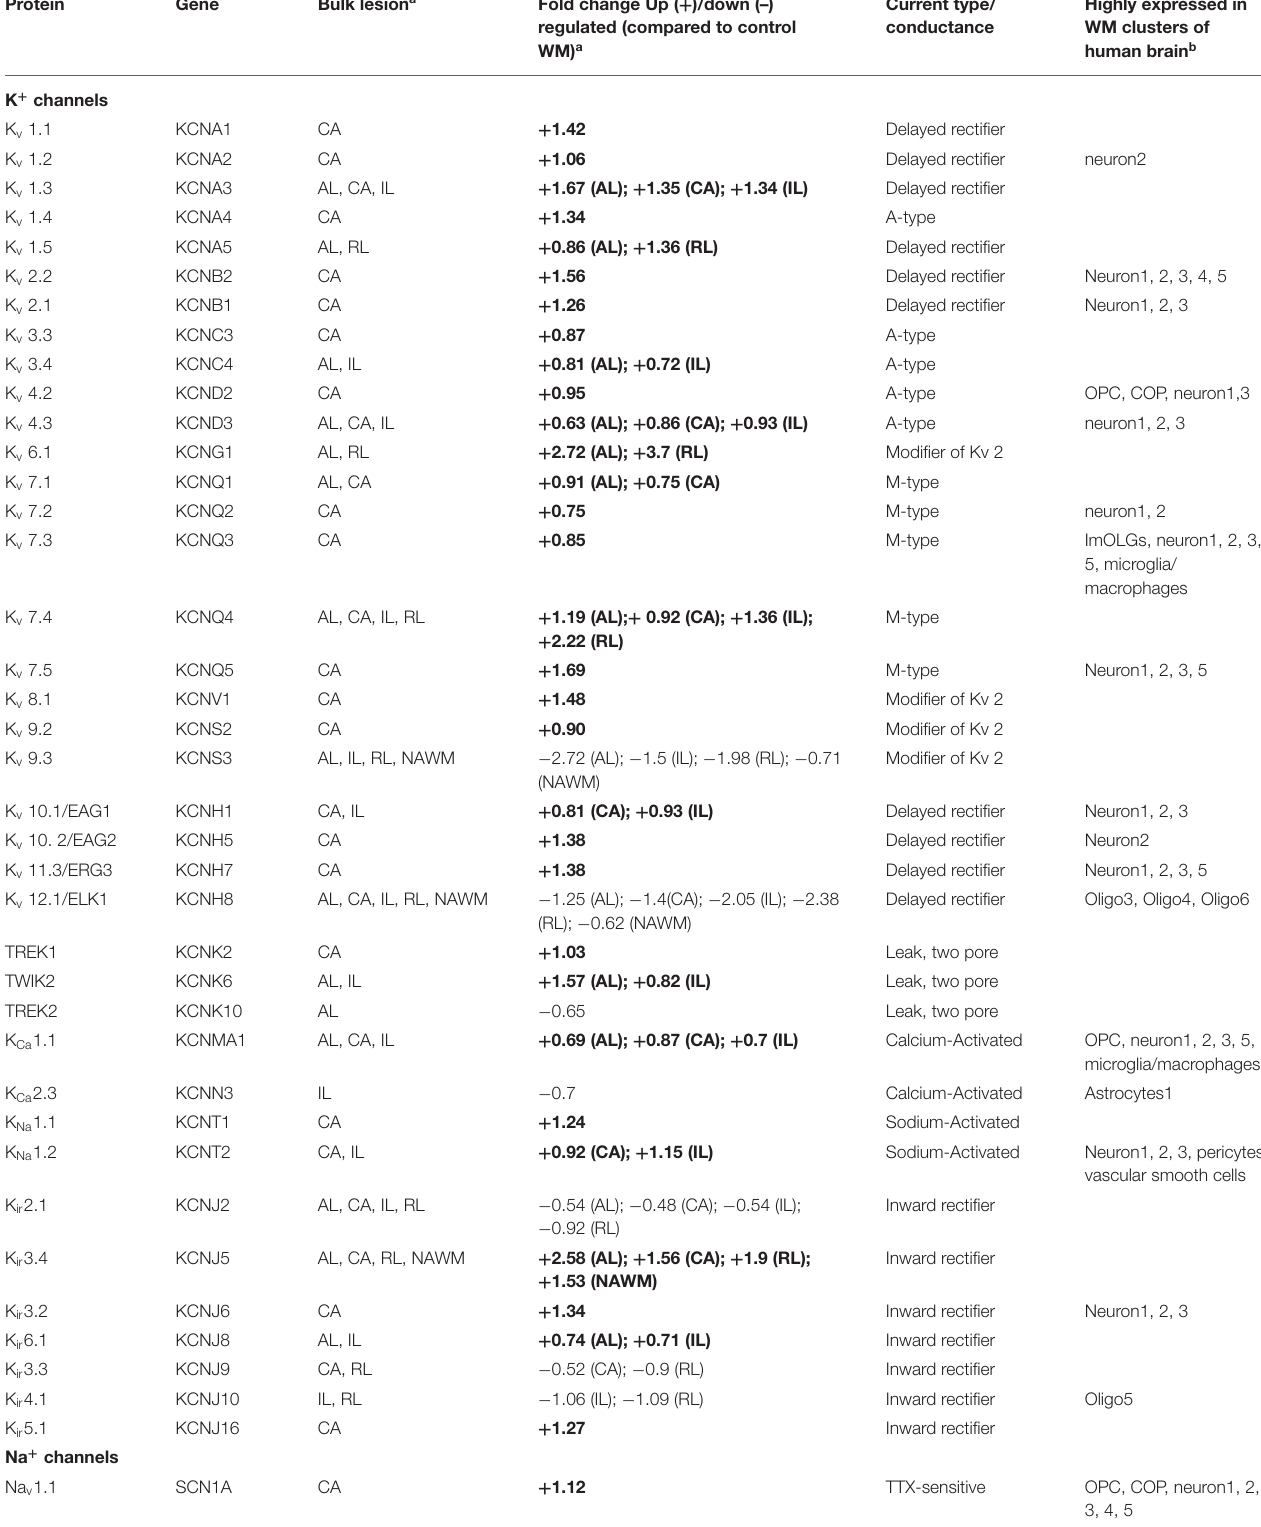
TABLE 1 | Expression and distribution of unique and overlapping genes coding for ion channels within SPMS lesions. Protein Gene Bulk lesion